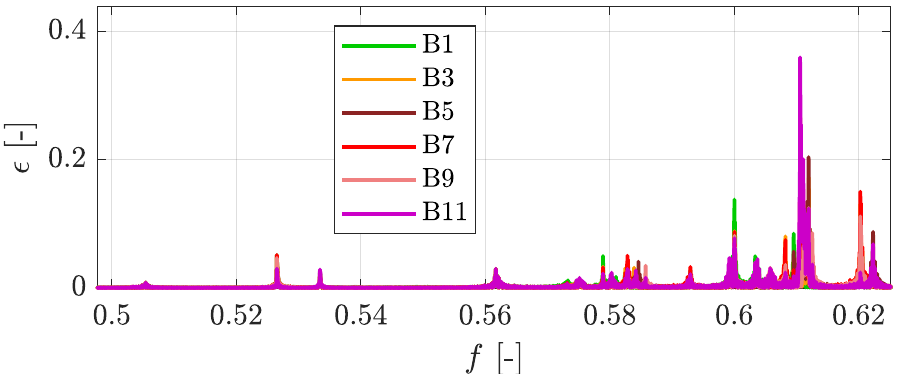
Figure 12. Overview of EO17 frequency region during M8EO24 resonance